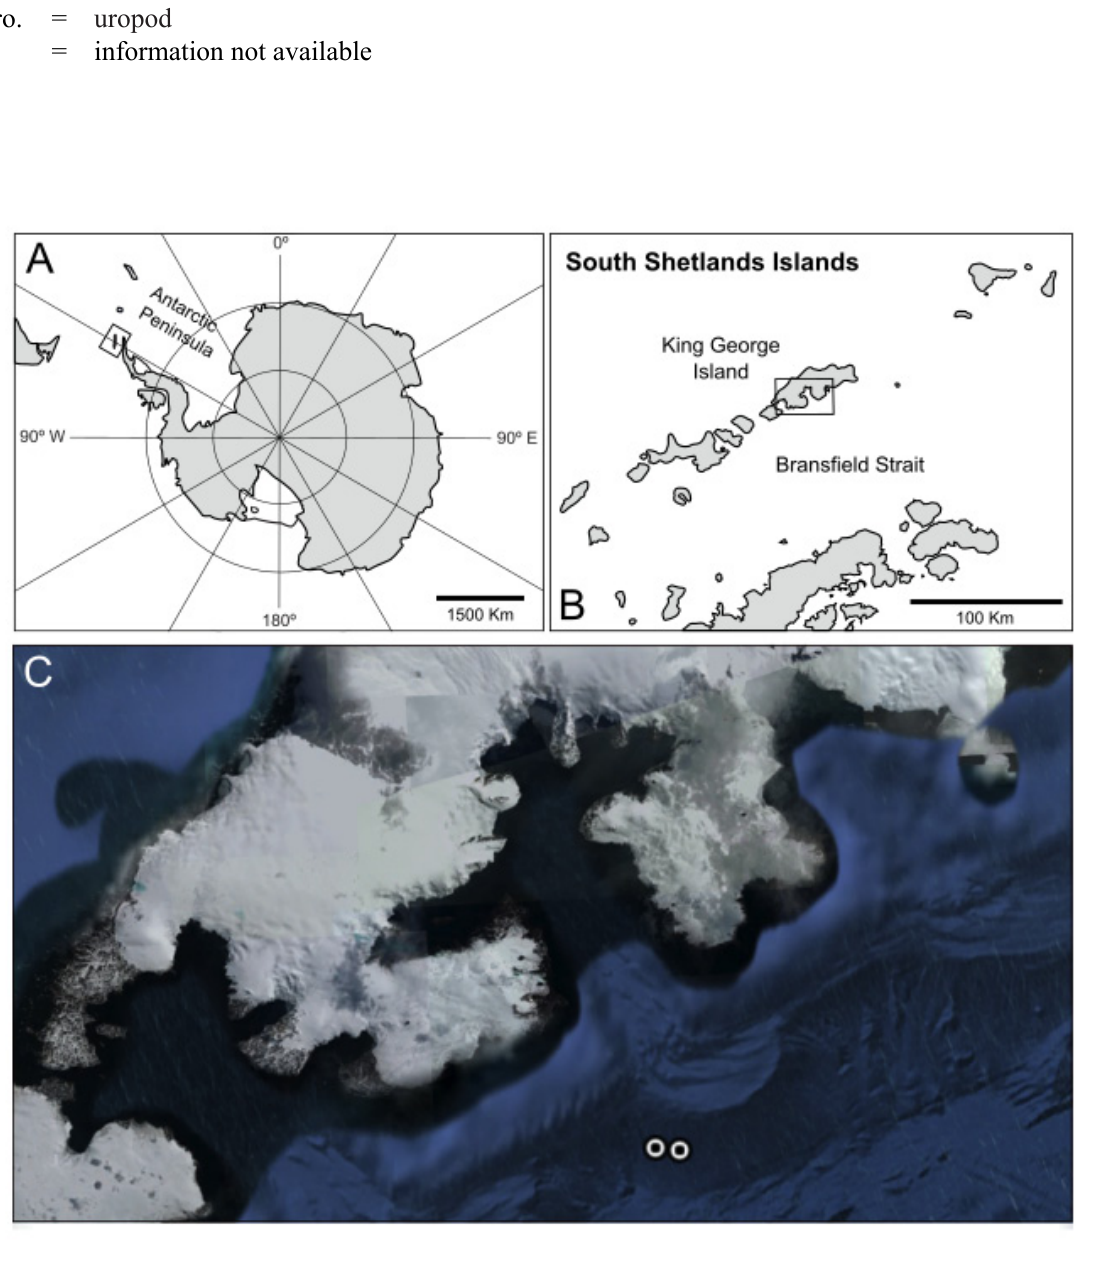
Fig. 1. A . Antarctic Continent. B . South Shetland Islands, King George Island (Admiralty Bay) and Bransfield Strait highlighted. C . Sampling sites in Bransfield Strait. (Source: Google